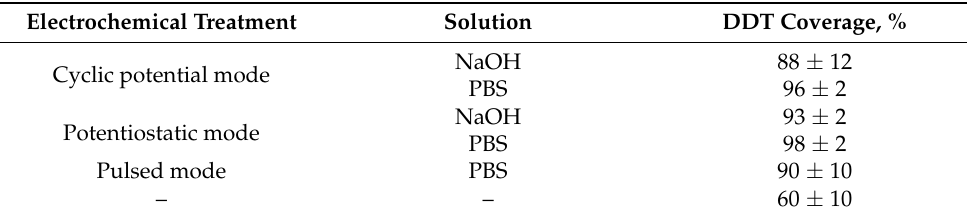
Table 2. Surface coverage of the gold electrode with DDT (16 h of immobilization) after different electrochemical pretreatments were applied.